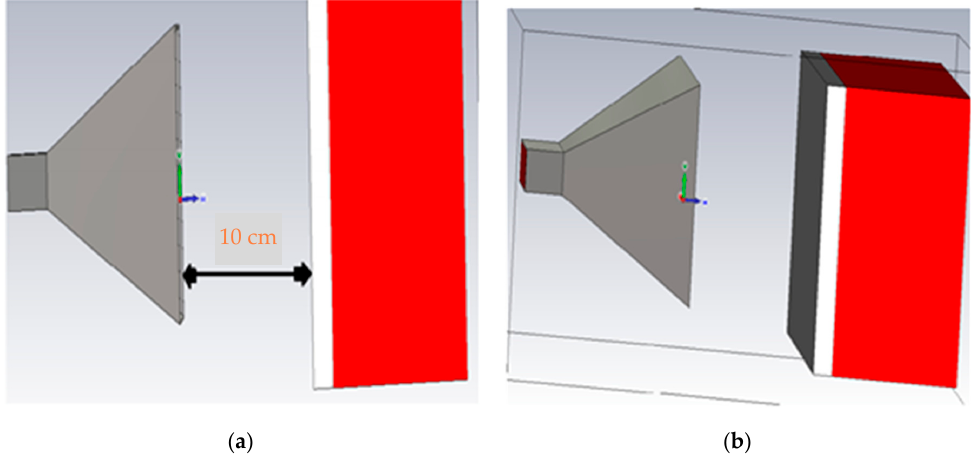
Figure 3. Layout for three-dimensional (3D) simulations: ( a ) Side view; ( b ) Perspective view.